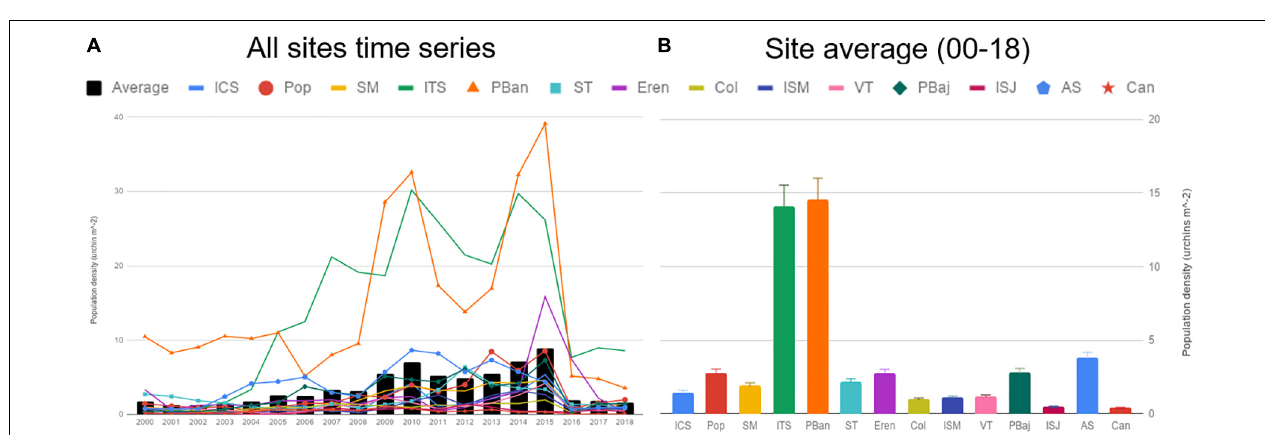
FIGURE 4 | Red sea urchin harvestable biomass (urchins > 80 mm) (A) , and harvest rate (%) (C) from 2000 to 2018, and the corresponding average per site (B,D) . Bars represent SE.